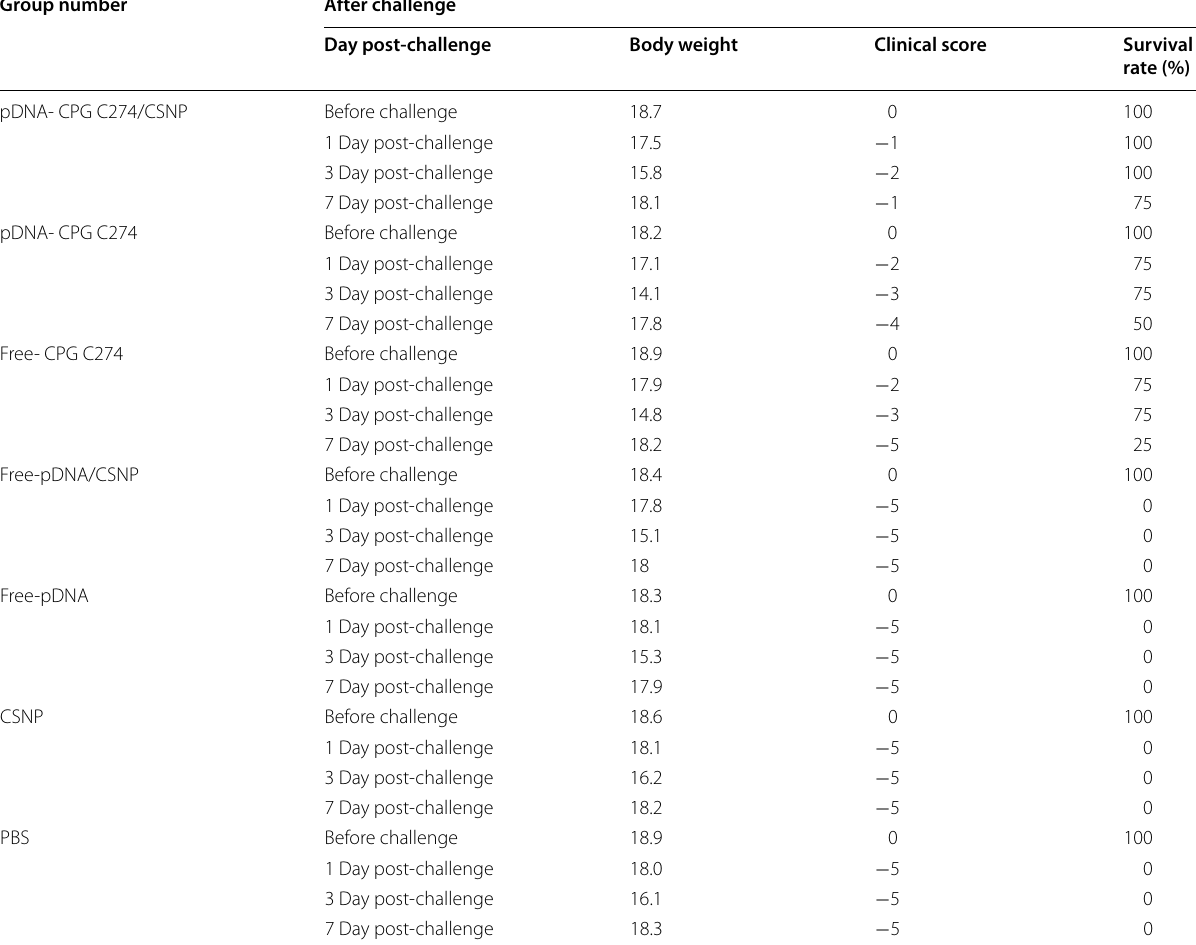
Table 2 Survival rates, body weight changes and clinical scores each day after A. baumannii